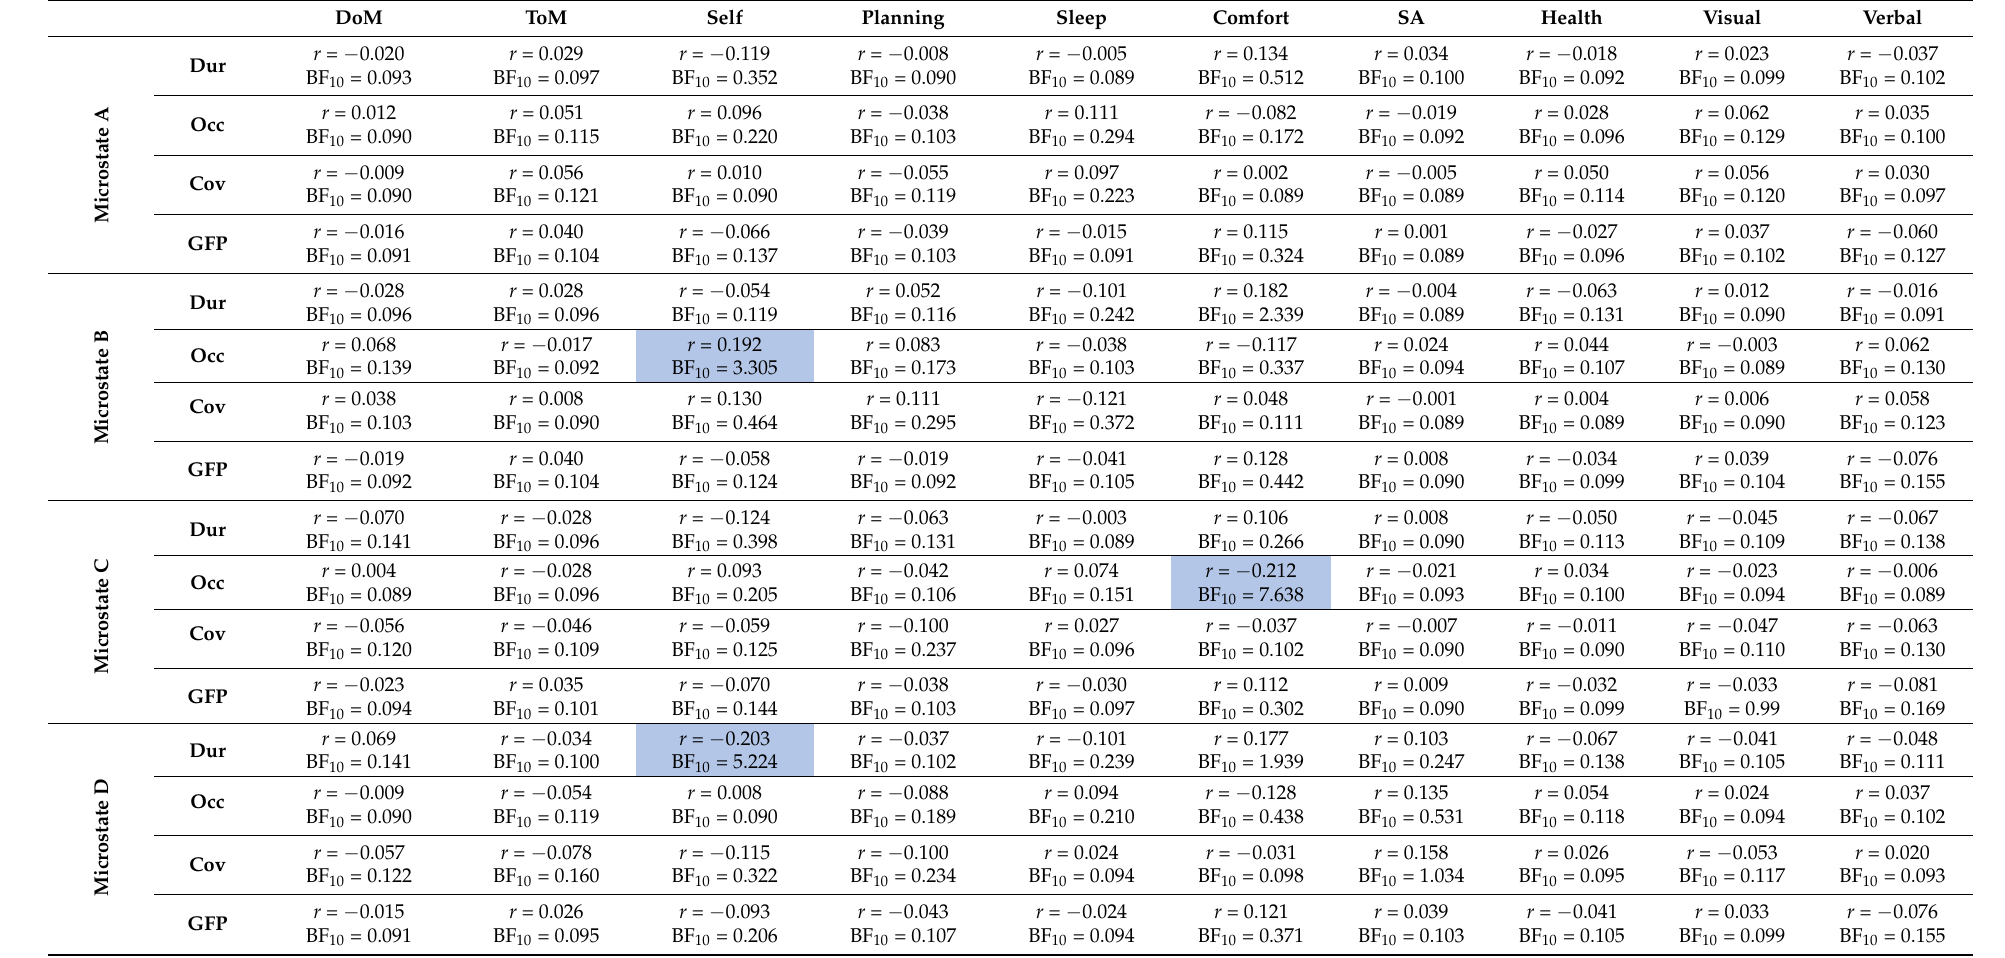
Table 2. Bayesian Pearson correlation coefficients between microstate characteristics and ARSQ